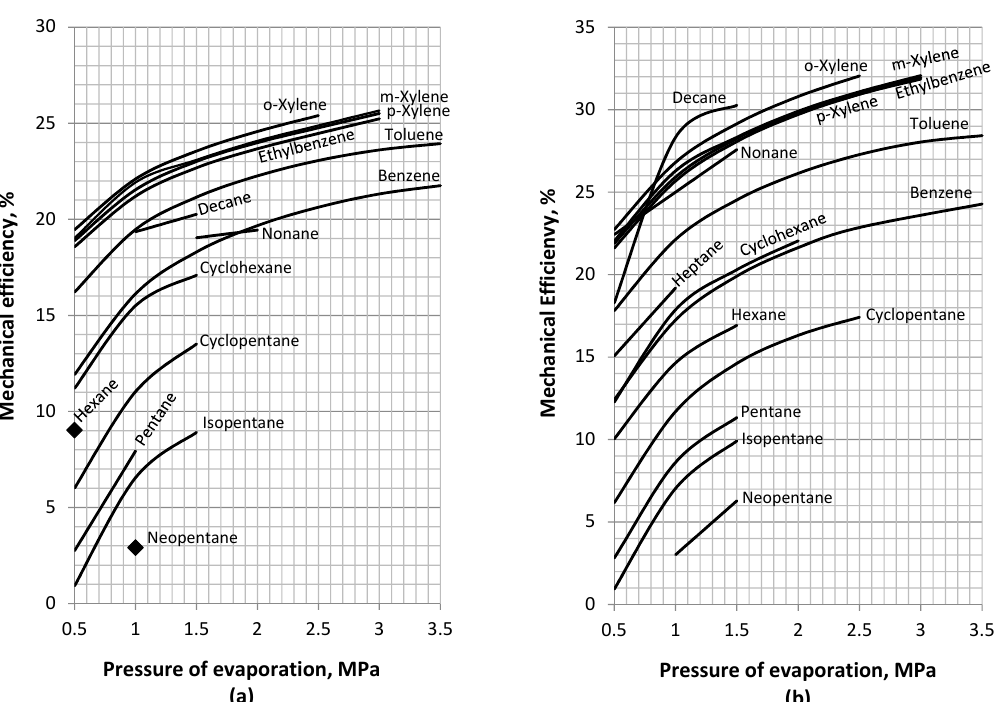
Figure 6. Effect of the evaporation pressure on the mechanical efficiency of the ORC cycle using hydrocarbons without regeneration ( a ) and with regeneration ( b ).